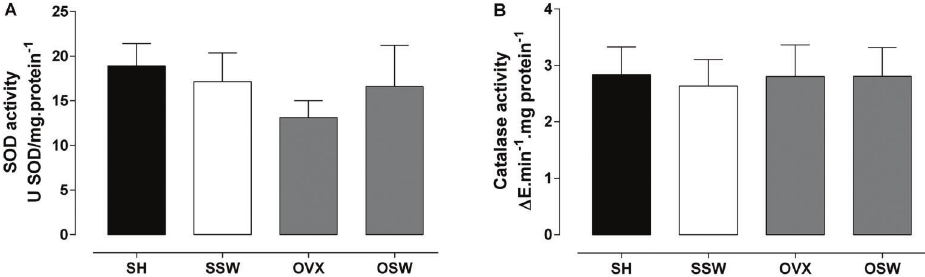
Figure 4. Enzymatic activity of antioxidant enzymes superoxide dismutase (SOD) ( A ) and catalase ( B ) in cardiac tissue. There were no differences among the groups. SH: sham-operated; SSW: sham plus swimming training; OVX: ovariectomized; OSW: ovariectomized plus swimming training. Data are reported as means ± SE (SH: n=4, SSW: n=5, OVX: n=5, OSW: n=5). P 4 0.05 (one-way ANOVA followed by Fisher ’ s post hoc test).